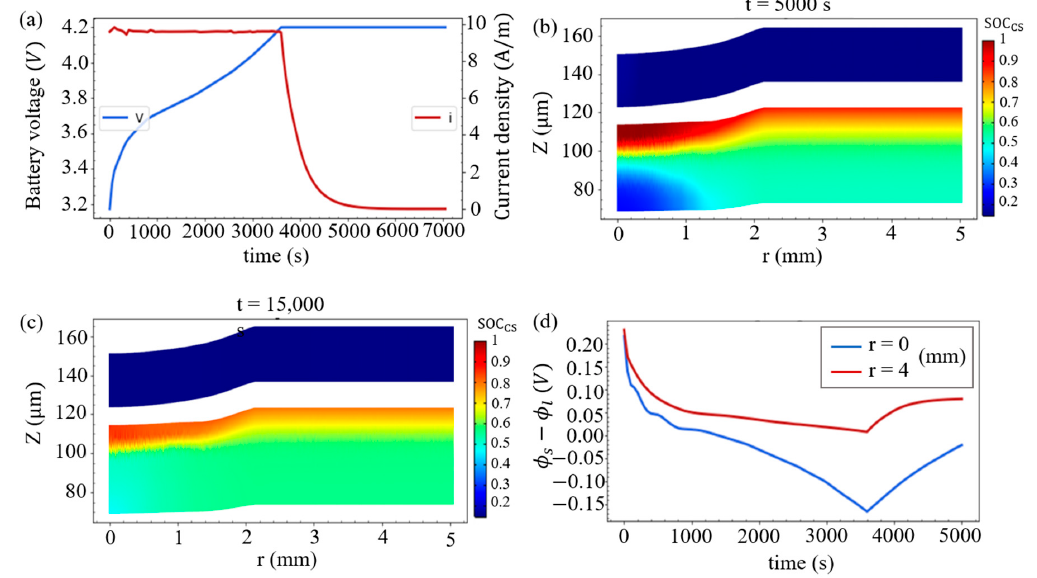
Figure 7. ( a ) Battery voltage and current density during the CCCV charging process. The SOC cs distributions in the two electrodes at ( b ) t = 5000 s and ( c ) t = 15,000 s. ( d ) Time evolutions of the SR overpotential at the junction of the negative electrode and the separator at r = 0 and r = 4 mm.